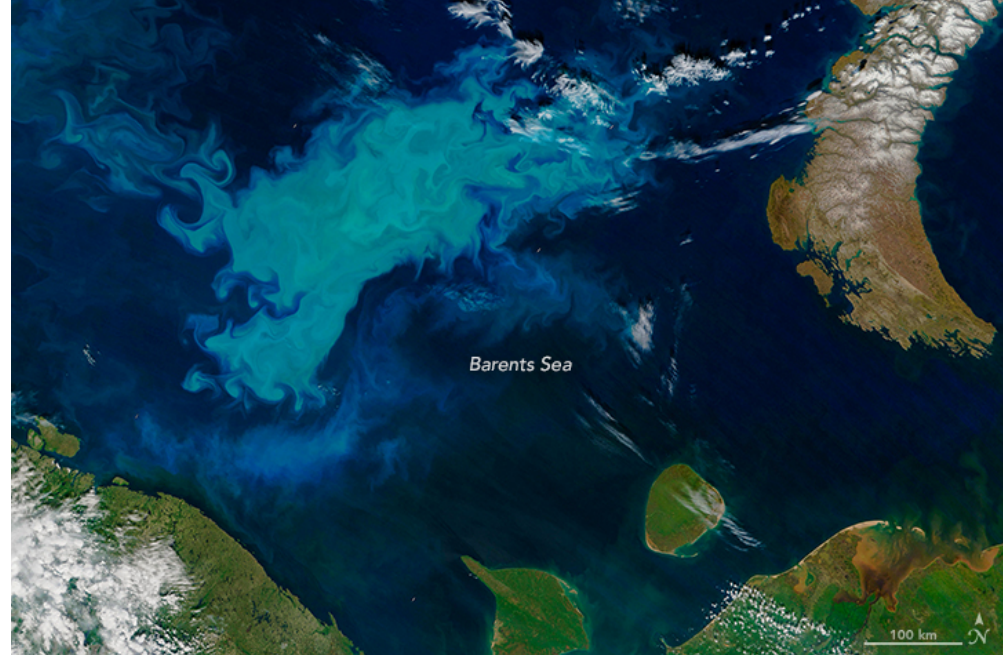
Figure 6. A phytoplankton bloom in the Barents Sea acquired by the Moderate Resolution Imaging Spectroradiometer (MODIS) on the Terra satellite on 6 July 2016. The phytoplankton may contain coccolithophores. The image is from the Rapid Response imagery of the Land, Atmosphere Near-real-time Capability for EOS (LANCE) system operated by the NASA Goddard Space Flight Center (GSFC) Earth Science Data and Information System